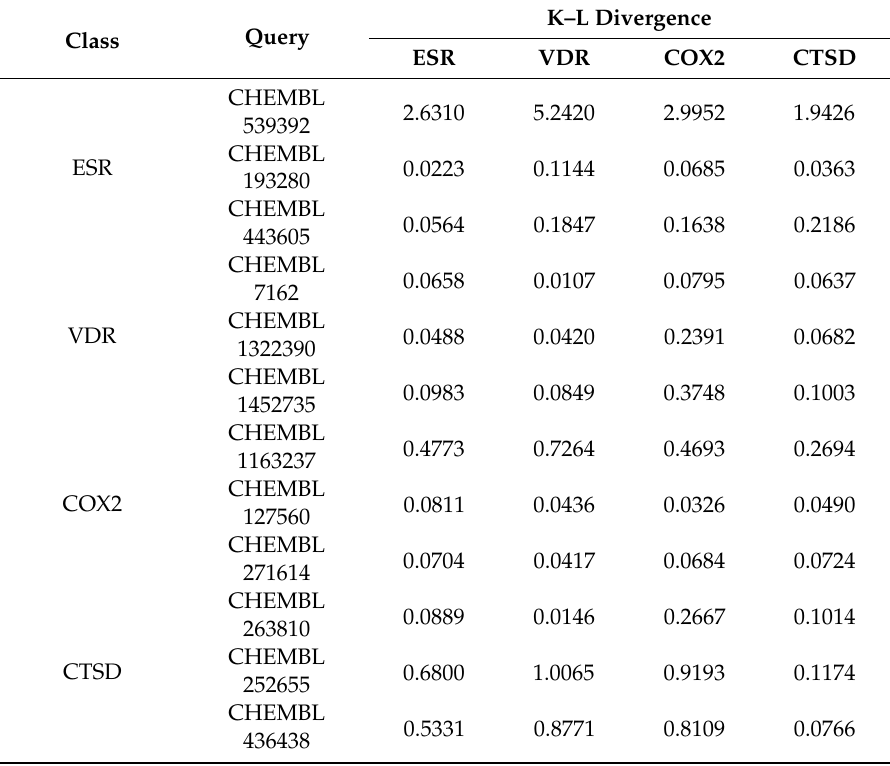
Table 2. K–L divergence of randomly chosen queries between Q distributions and the distributions of